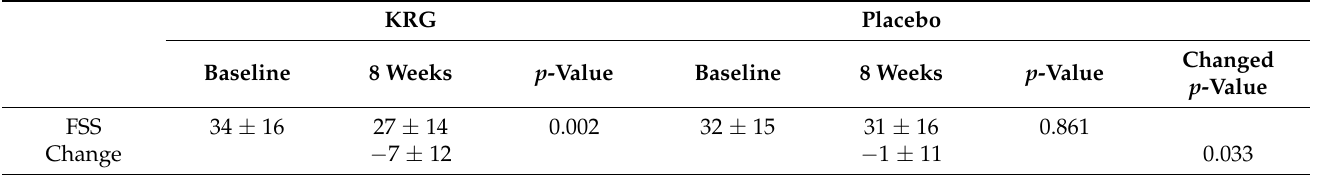
Table 4. Changes in questionnaire scores (FSS) of the KRG and placebo groups before and after 8